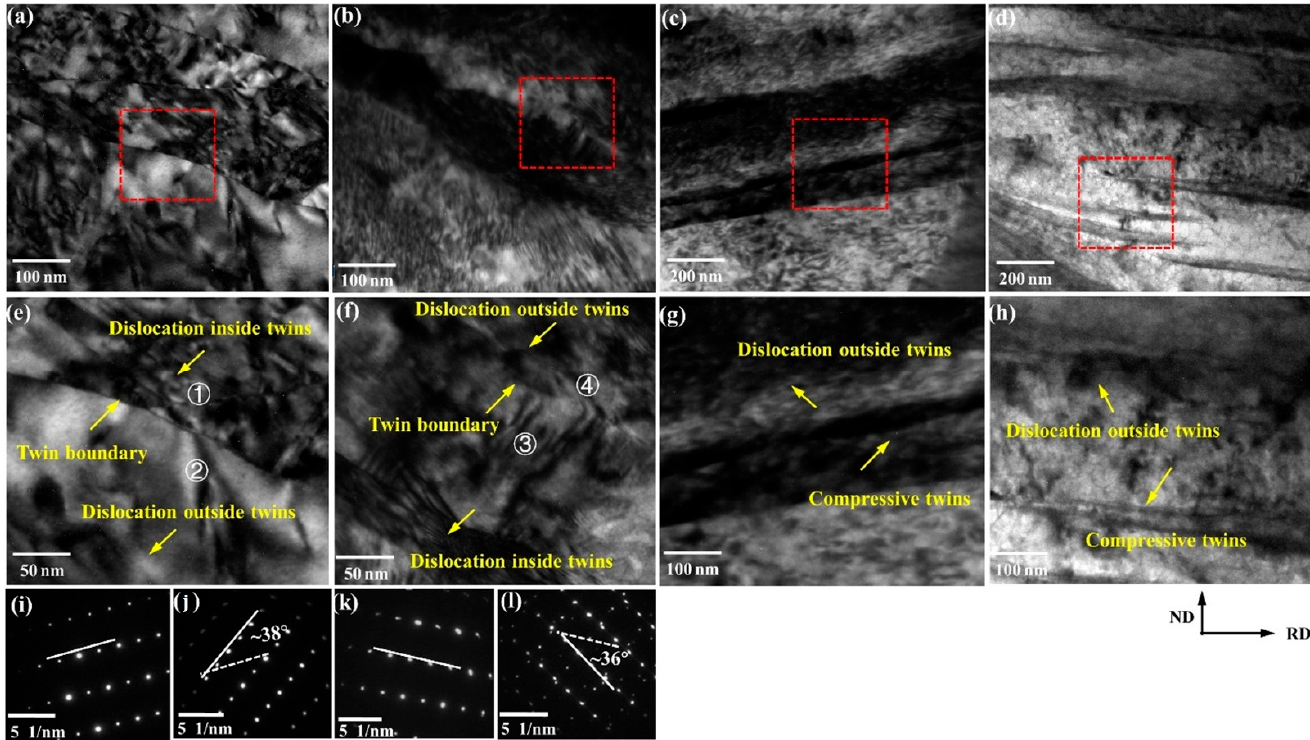
Figure 7. The content of small-angle grain boundaries and grain boundaries with three kinds of twin orientations of the ( a , e ) CR30%, ( b , f ) CR50%, ( c , g ) RR30%, and ( d , h ) RR50% plates. ( i – l ) The diffraction patterns taken from the region 1, 2, 3 and 4.